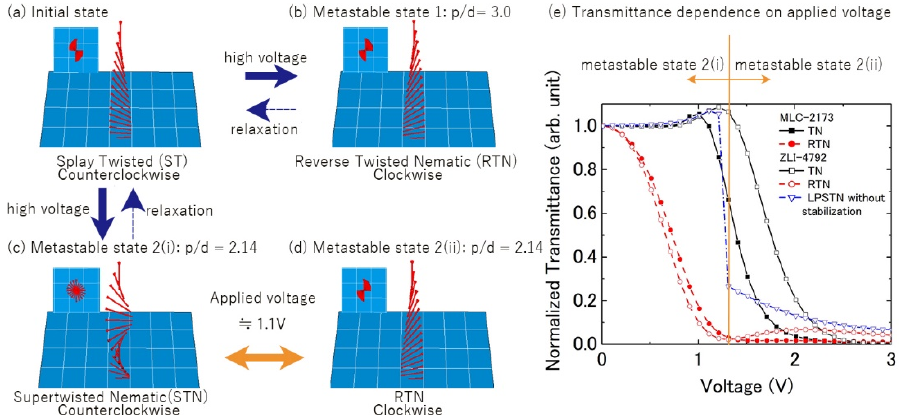
Figure 1. Schematic diagrams of LC structures; ( a ) initial state, ST; ( b ) metastable state 1, RTN; ( c ) metastable state 2a, LPSTN; ( d ) metastable state 2b, RTN. The ST structure changed to the metastable state ( b ) RTN or ( c ) LPSTN by high voltage application when the p/d ratio was 3.0 or 2.14. ( e ) Dependence of transmittance on the applied voltage for TN-LCDs (cell thickness of 5.0 µm), RTN-LCDs (chiral pitch of 15.0 µm, cell thickness of 5.0 µm, RM), and LPSTN-LCD (chiral pitch of 15.0 µm, cell thickness of 7.0 µm) [9,14]. Solid symbols indicate MLC-2173 and open symbols indicate ZLI-4792.